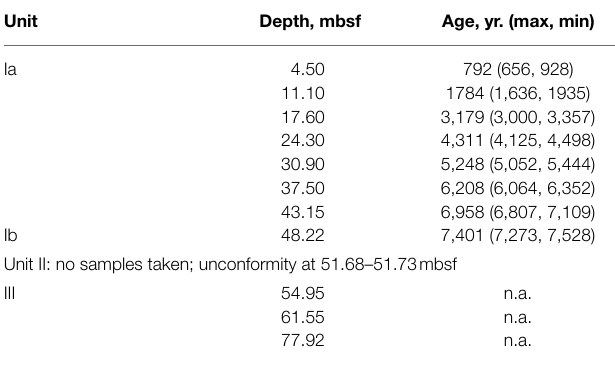
TABLE 1 | Depths sampled for enzyme activities, corresponding ages interpolated from the model of van Helmond et al. (2017), and stratigraphic units as described by Andrén et al.